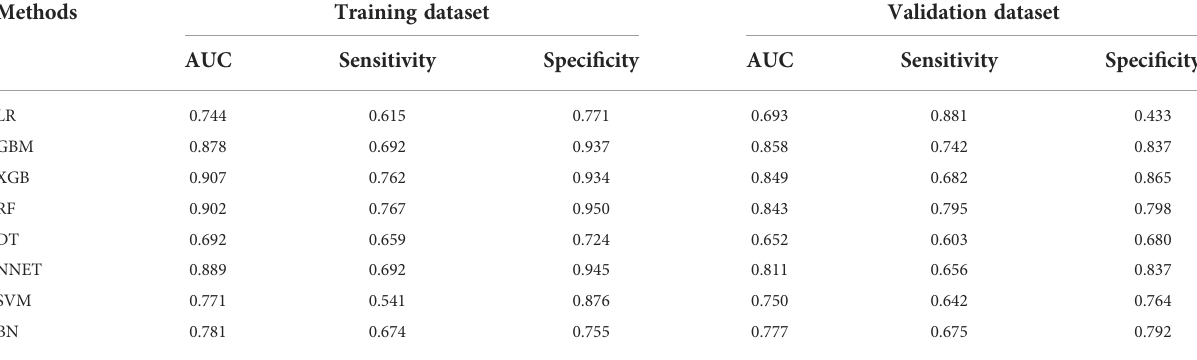
TABLE 2 Predictive performance comparison of the eight types of machine learning algorithms in the training and validation dataset. Methods